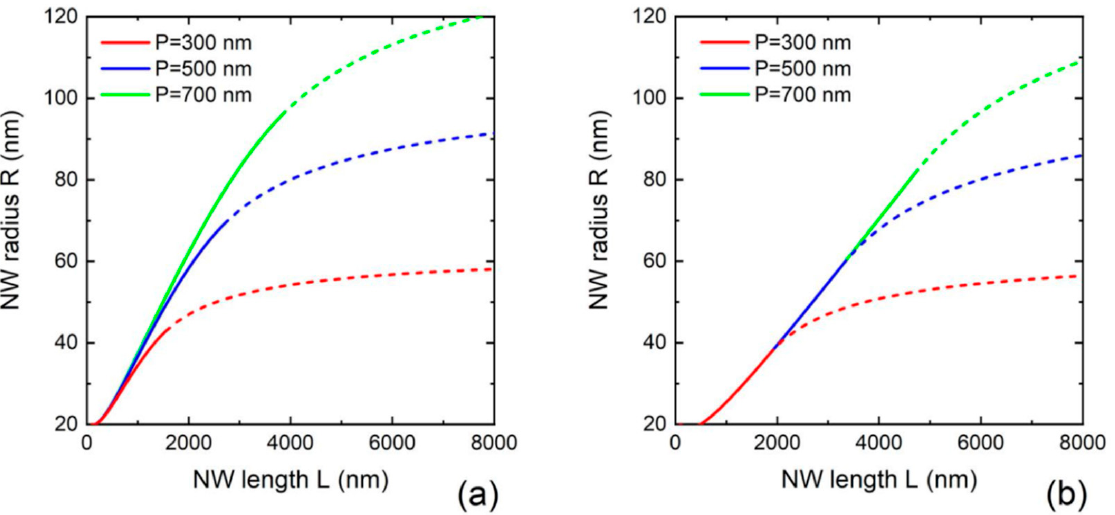
Figure 3. Evolution of the NW radius with length in MBE growth on ( a ) reflecting and ( b ) adsorbing substrates for three different pitches P shown in the legends. The curves are obtained from Equation (14) in ( a ) and Equation (12) in ( b ) at the fixed R 0 = 20 nm, v 3 / v 5 = 0.31, α 3 = α 5 = 30 ◦ , c = 1, and β = 135 ◦ . The solid and dashed lines show the morphological evolution before and after the full shadowing of the substrate surface, respectively.